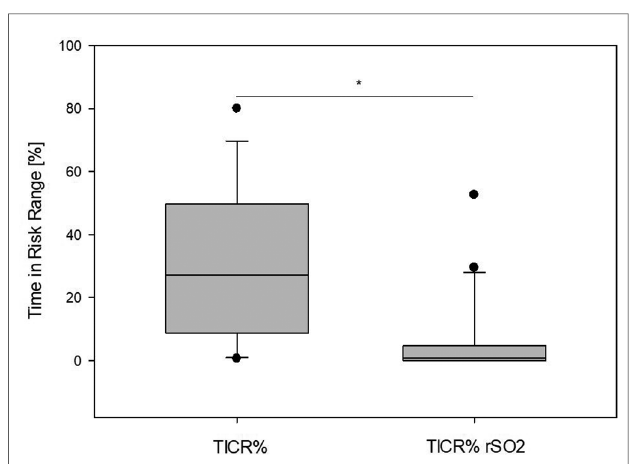
FIGURE 5 Two means of cerebral perfusion monitoring were compared. The left box indicates the percentage time of actual blood pressure outside the identi fi ed autoregulated range (TICR%). The right box indicates the percentage time when cerebral oximetry decreased by >20% from the baseline value (TICR% rSO 2 ). According to the Shapiro – Wilk test, the data are non-normally distributed. Therefore, the Mann – Whitney rank sum test was performed, which revealed signi fi cant differences in mean values ( p <0.001).